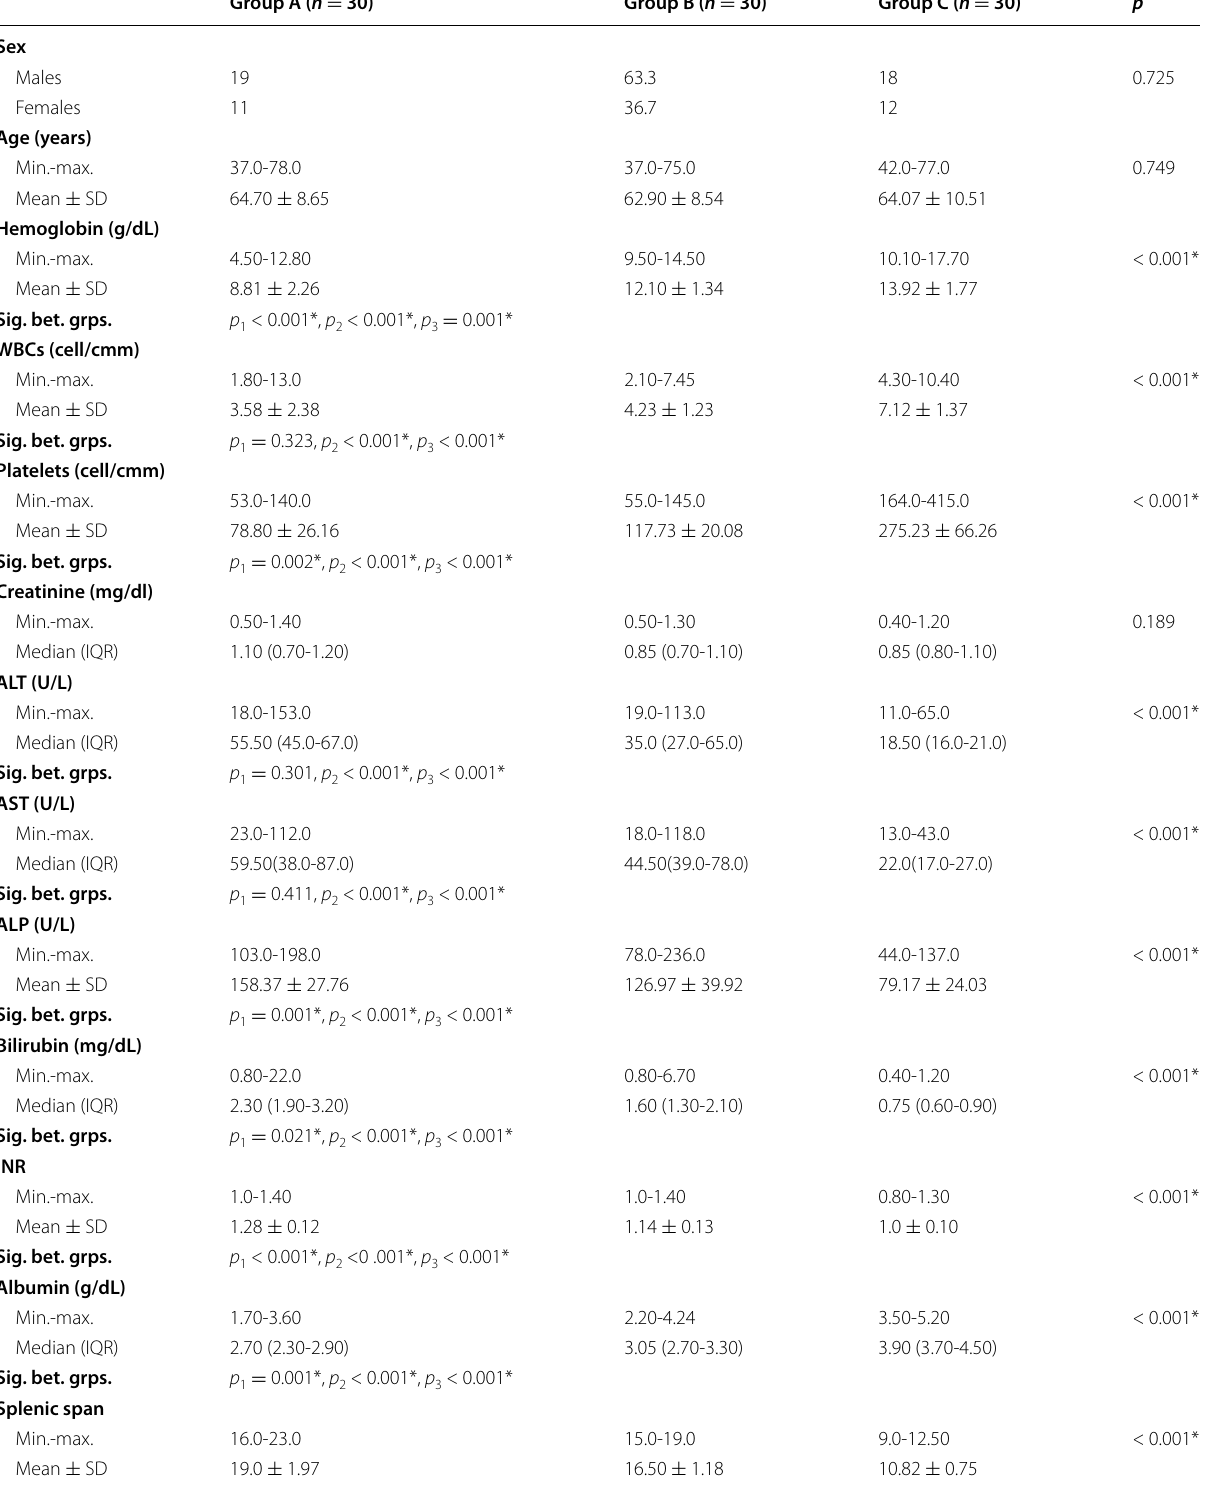
Table 1 Comparison between the studied groups according to demographic data, complete blood count, creatinine, ALT, AST, ALP, bilirubin, INR, albumin, splenic bipolar diameter, and portal vein diameter by ultrasound abdomen and APRI Group A ( n 30) Group B ( n =